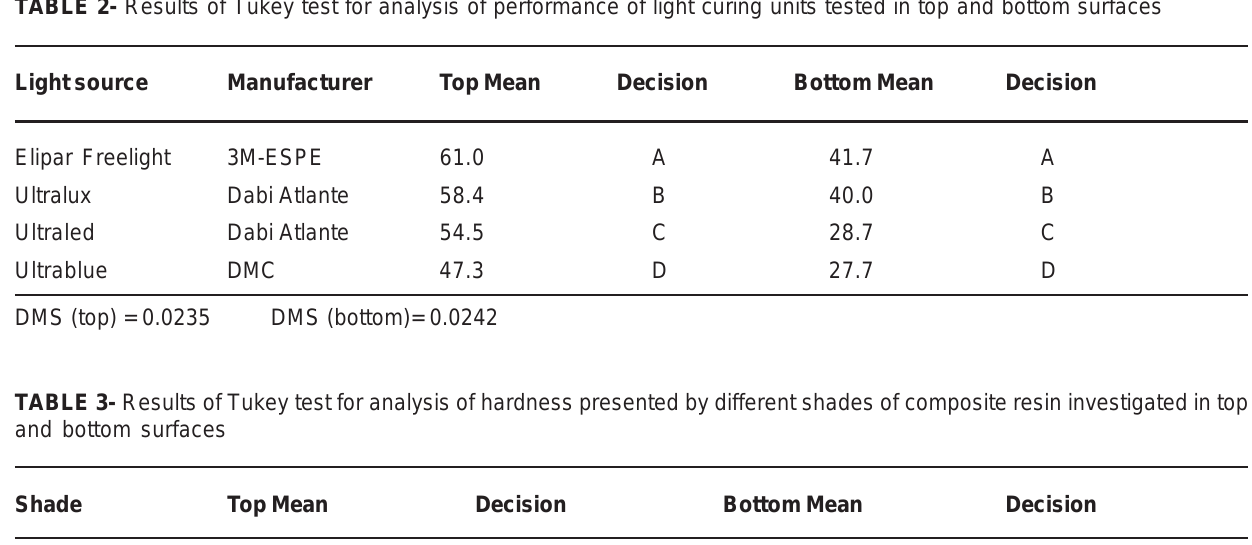
TABLE 2- Results of Tukey test for analysis of performance of light curing units tested in top and bottom surfaces